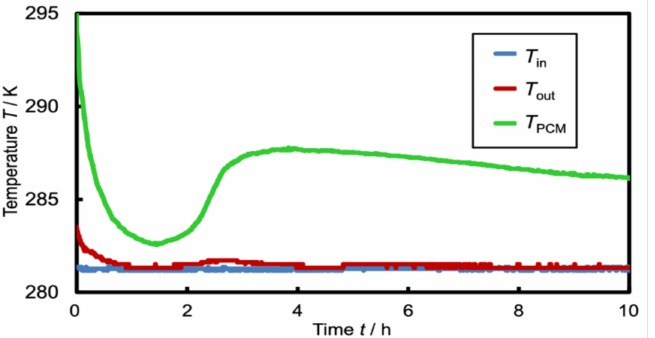
Figure 3. Time evolutions of the temperature at inlet of the chiller (T in ), outlet (T out ) of the chiller and thermal energy storage medium (T PCM ) in the static